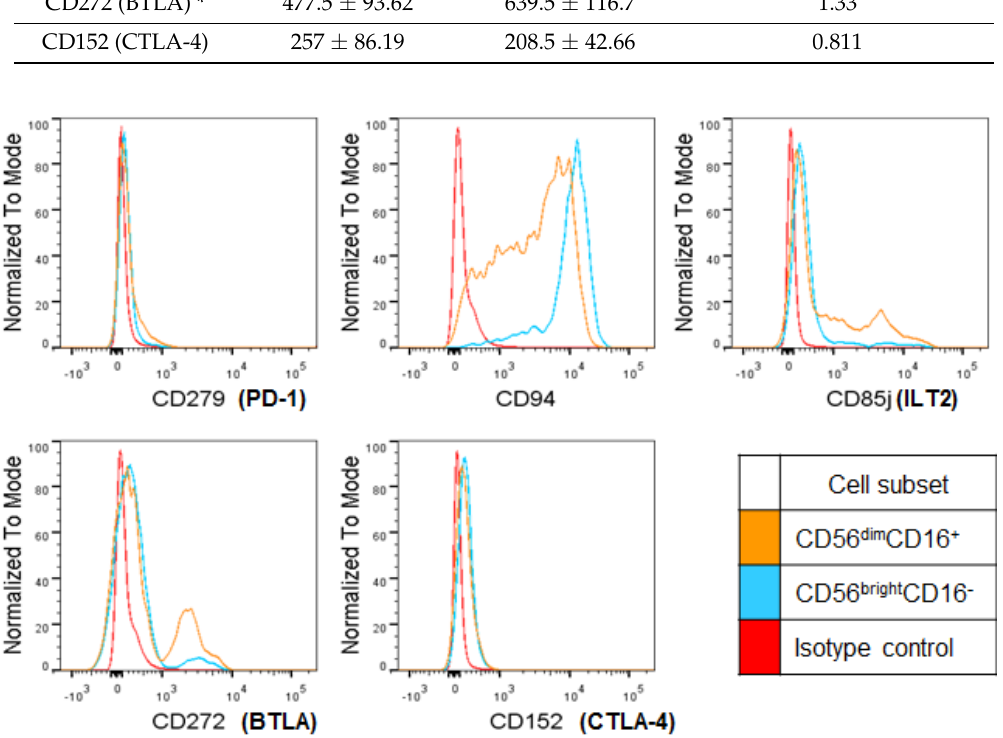
Figure 3. Inhibitory receptor expression on CD56 bright and CD56 dim HI NK cells. Representative plots of inhibitory receptors on the surface of HI NK cells are shown. n = 10.